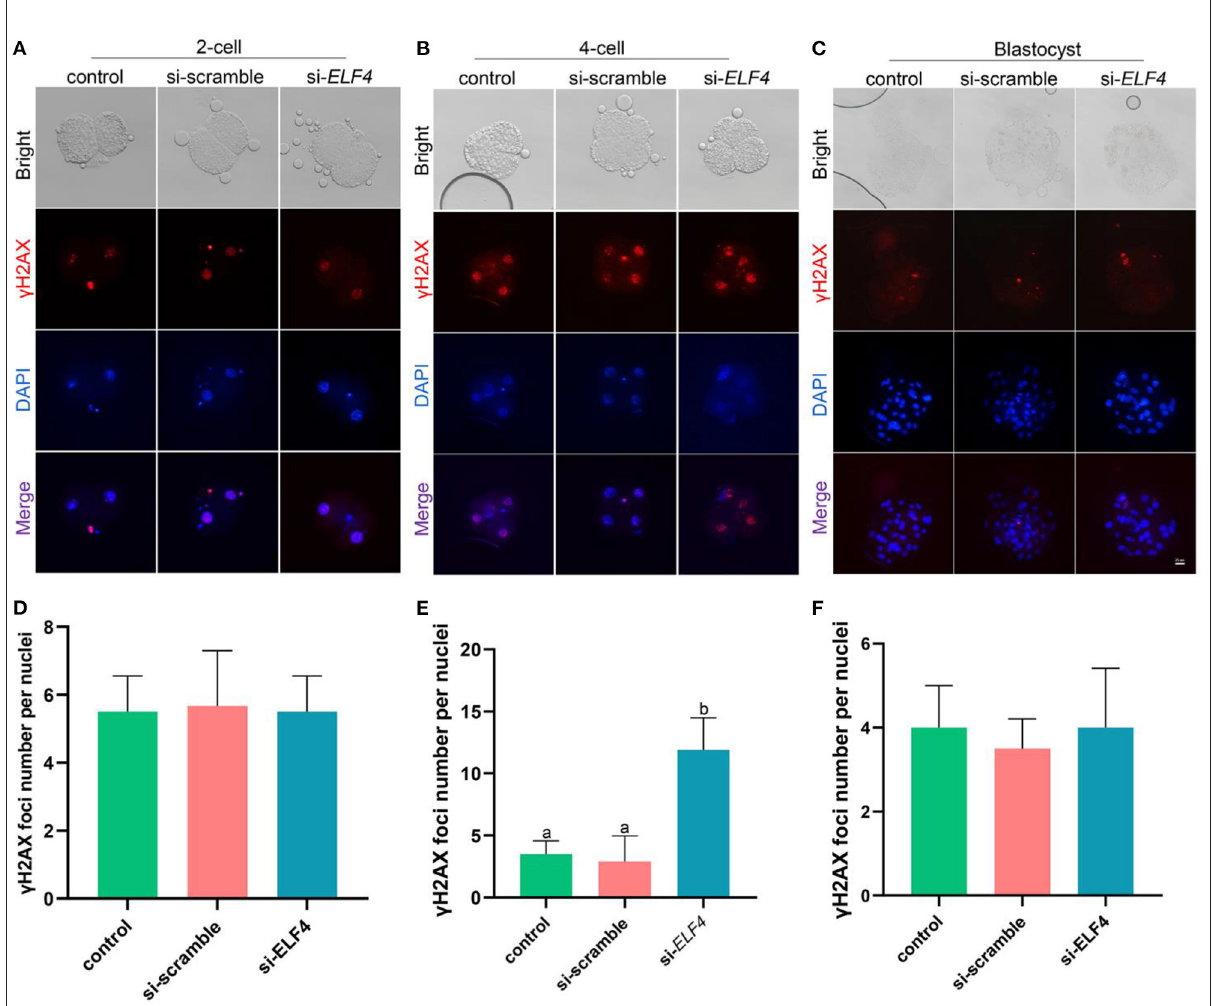
FIGURE5 Effects of ELF4 on DNA damage during preimplantation development of porcine IVF embryos. (A–C) Immunofluorescence staining of γ H2AX foci in the control, si-scramble, and si- ELF4 embryos at the 2-cell, 4-cell and blastocyst stages. Scale bars represented 25 µ m. (D–F) Semi-quantitative fluorescence intensity analysis of the γ H2AX staining at the 2-cell, 4-cell and blastocyst stages. Different lowercase letters indicate statistical differences ( p <